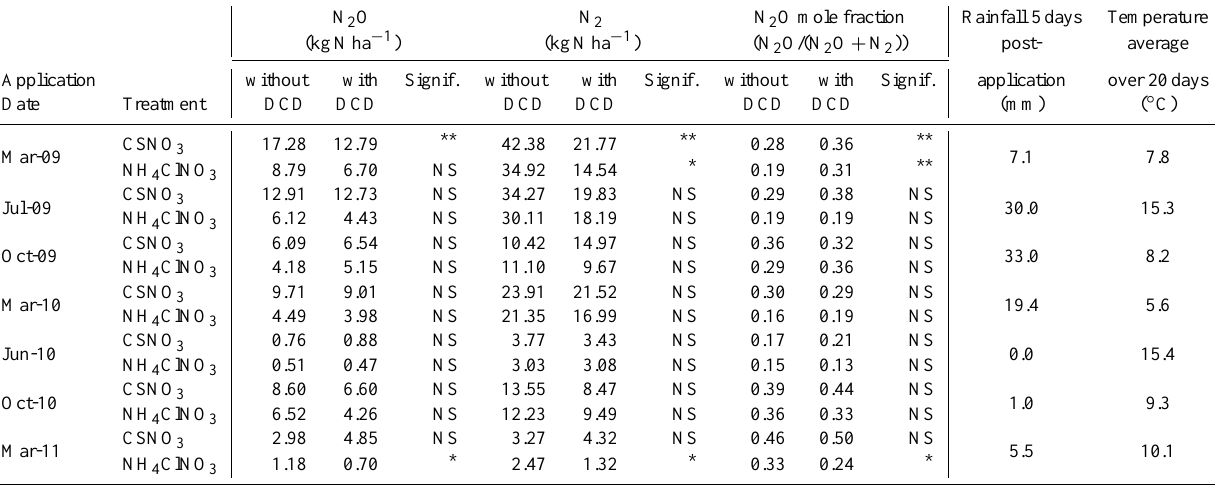
Table 2. Cumulative fluxes of N 2 O and N 2 evolved over 20days after treatment application for CSNO 3 and NH 4 ClNO 3 with and without DCD.